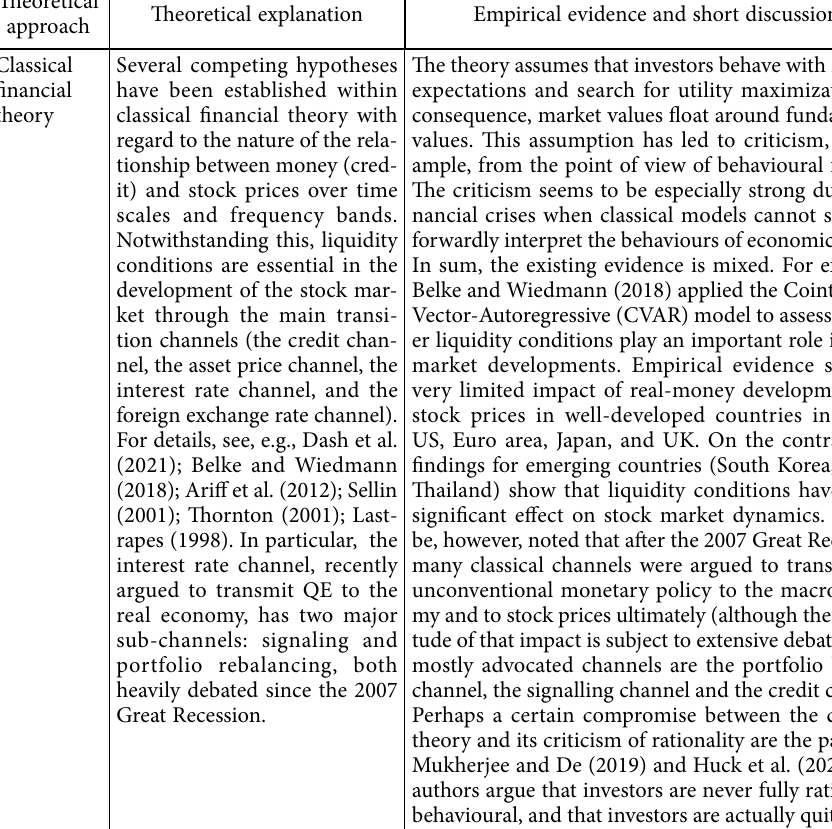
Table 1. The main theories and empirical evidence (source: own work) Theoretical